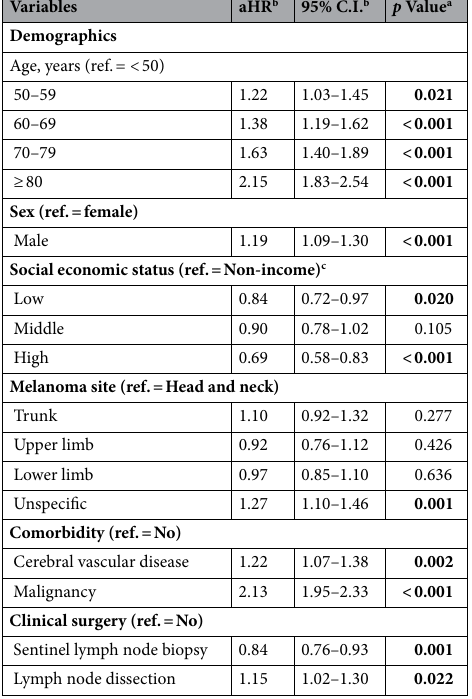
Fig. 2. The 5-year survival rates of patients with high, middle, low and non-income SES were 51.4%, 33.3%, 36.1% and 29.6%, respectively. The 5-year survival rates of patients undergoing SLNB and not undergoing SLNB were 45.5% and 33.6%. Multivariate analysis. In the univariate analysis, age, sex, SES, comorbidity, site of melanoma, undergoing SLNB and LND were significantly associated with prognosis. To avoid confounding and to better reflect inde- pendent prognostic factors, Table 2 provides the multivariate analysis of these factors. Patients aged ≥ 80 years [adjusted hazard ratio (aHR) = 2.15], between 70 and 79 years of age (aHR = 1.63), between 60 and 69 years of age (aHR = 1.38) or between 50 and 59 years of age (aHR = 1.22) had a worse prognosis than patients aged less than 50 years. Male gender was associated with a worse survival (aHR = 1.19) than female gender. The aHRs for low, middle and high SES were 0.84 (95% CI 0.72–0.97), 0.90 (95% CI 0.78–1.02) and 0.69 (95% CI 0.58–0.83), respectively, compared with non-income group. Comorbidities including diabetes, coronary artery disease and heart failure were significantly poor prognostic factors in univariate analysis, but was not significant in multivar- iate analysis. Cerebral vascular disease (aHR = 1.22, P = 0.002) and malignancy (aHR = 2.13, P < 0.001) remained significant poor prognostic factors in multivariate analysis. Undergoing SLNB (aHR = 0.84, P = 0.001) and LND (aHR = 1.15, P = 0.022) were also significantly prognostic factors in multivariate analysis. Sentinel lymph node biopsy.